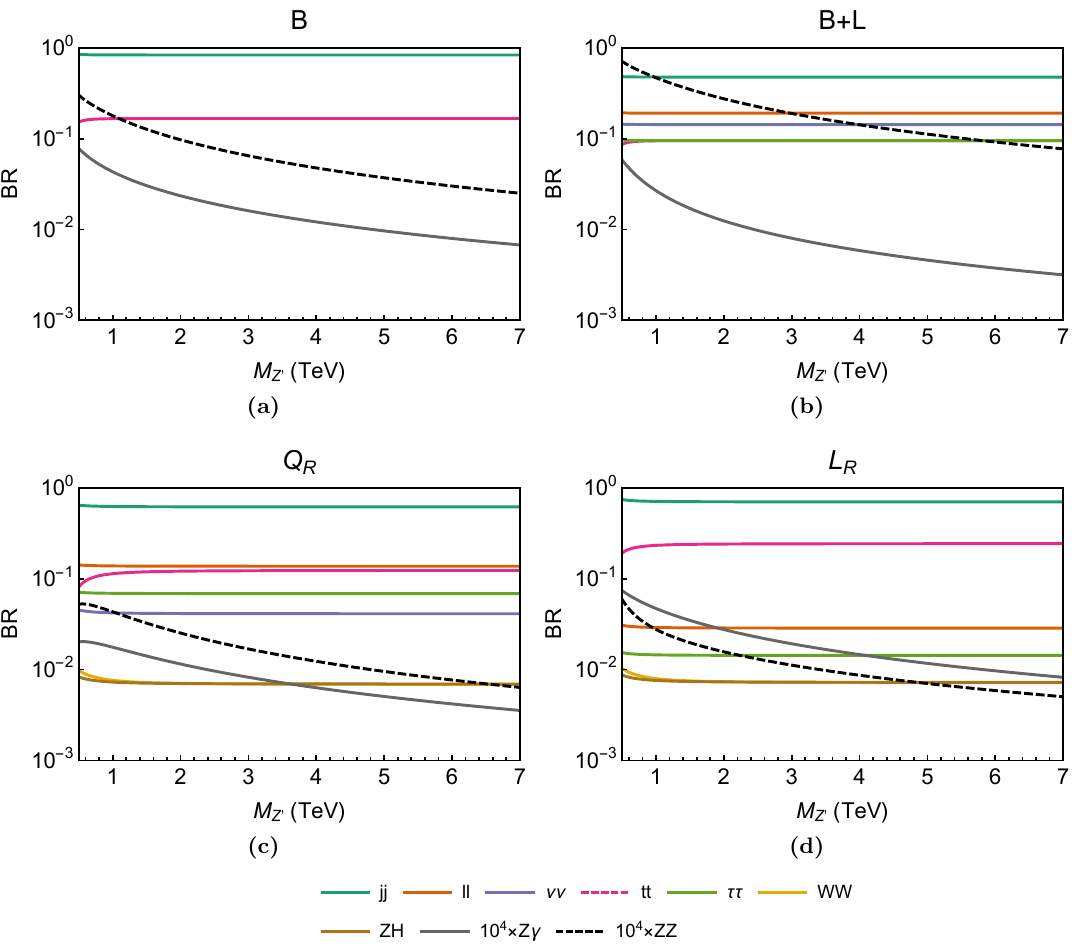
Figure 2. Branching ratios of Z 0 as functions of M Z 0 for the benchmark models given in table 3. The gauge coupling is chosen to the representative value g z = 0 : 2. Note the enhancement of a factor of 10 4 of the loop-suppressed branching